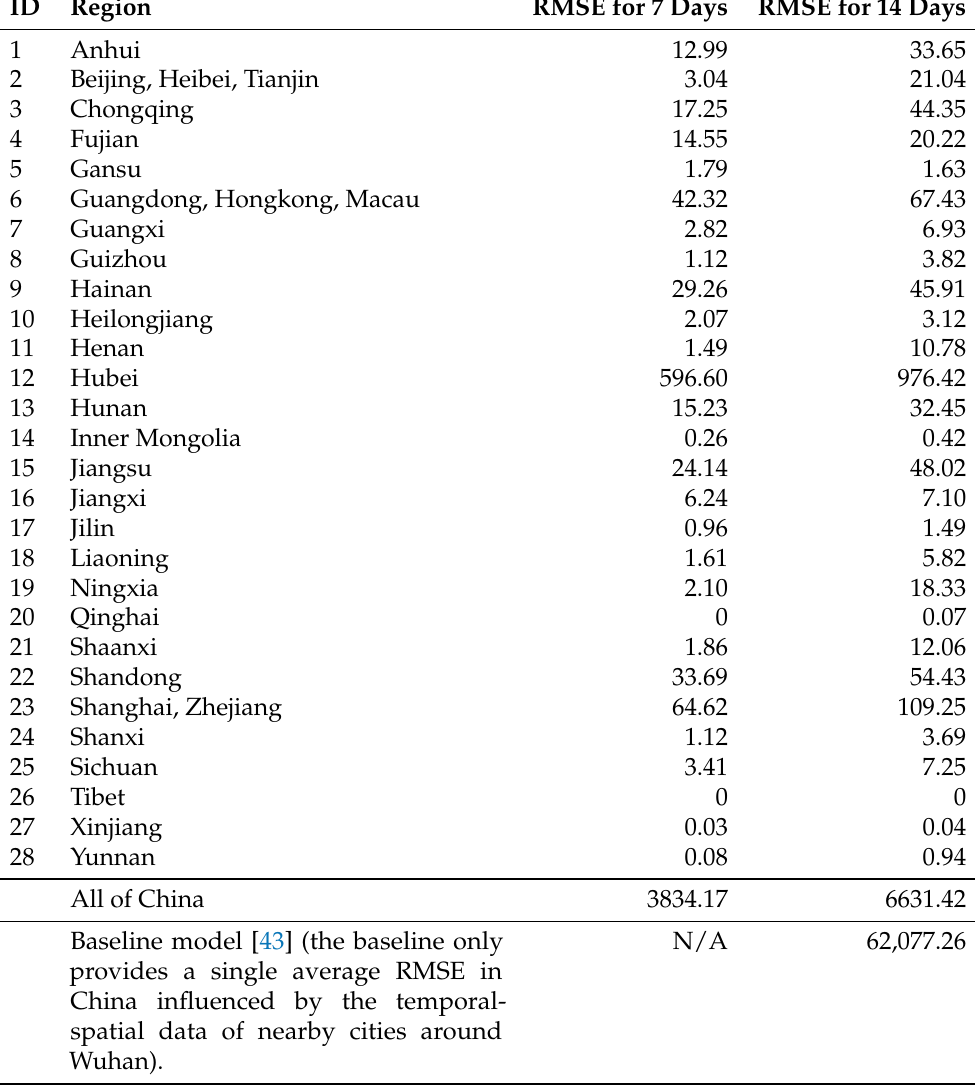
Table 2. RMSE for 7- and 14-day